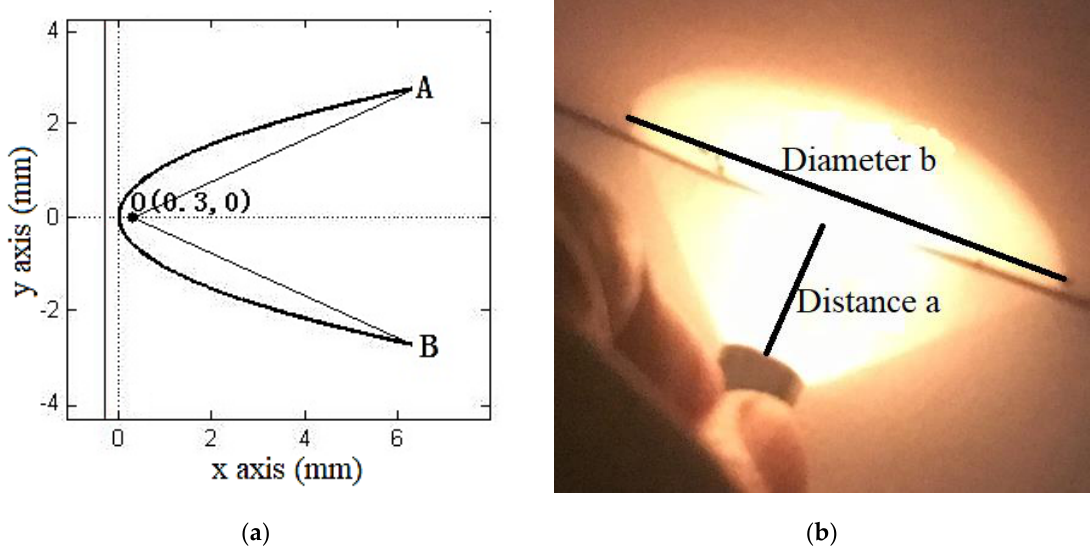
Figure 1. ( a ) The mathematical model and ( b ) experimental tests of paraboloid concentrator.